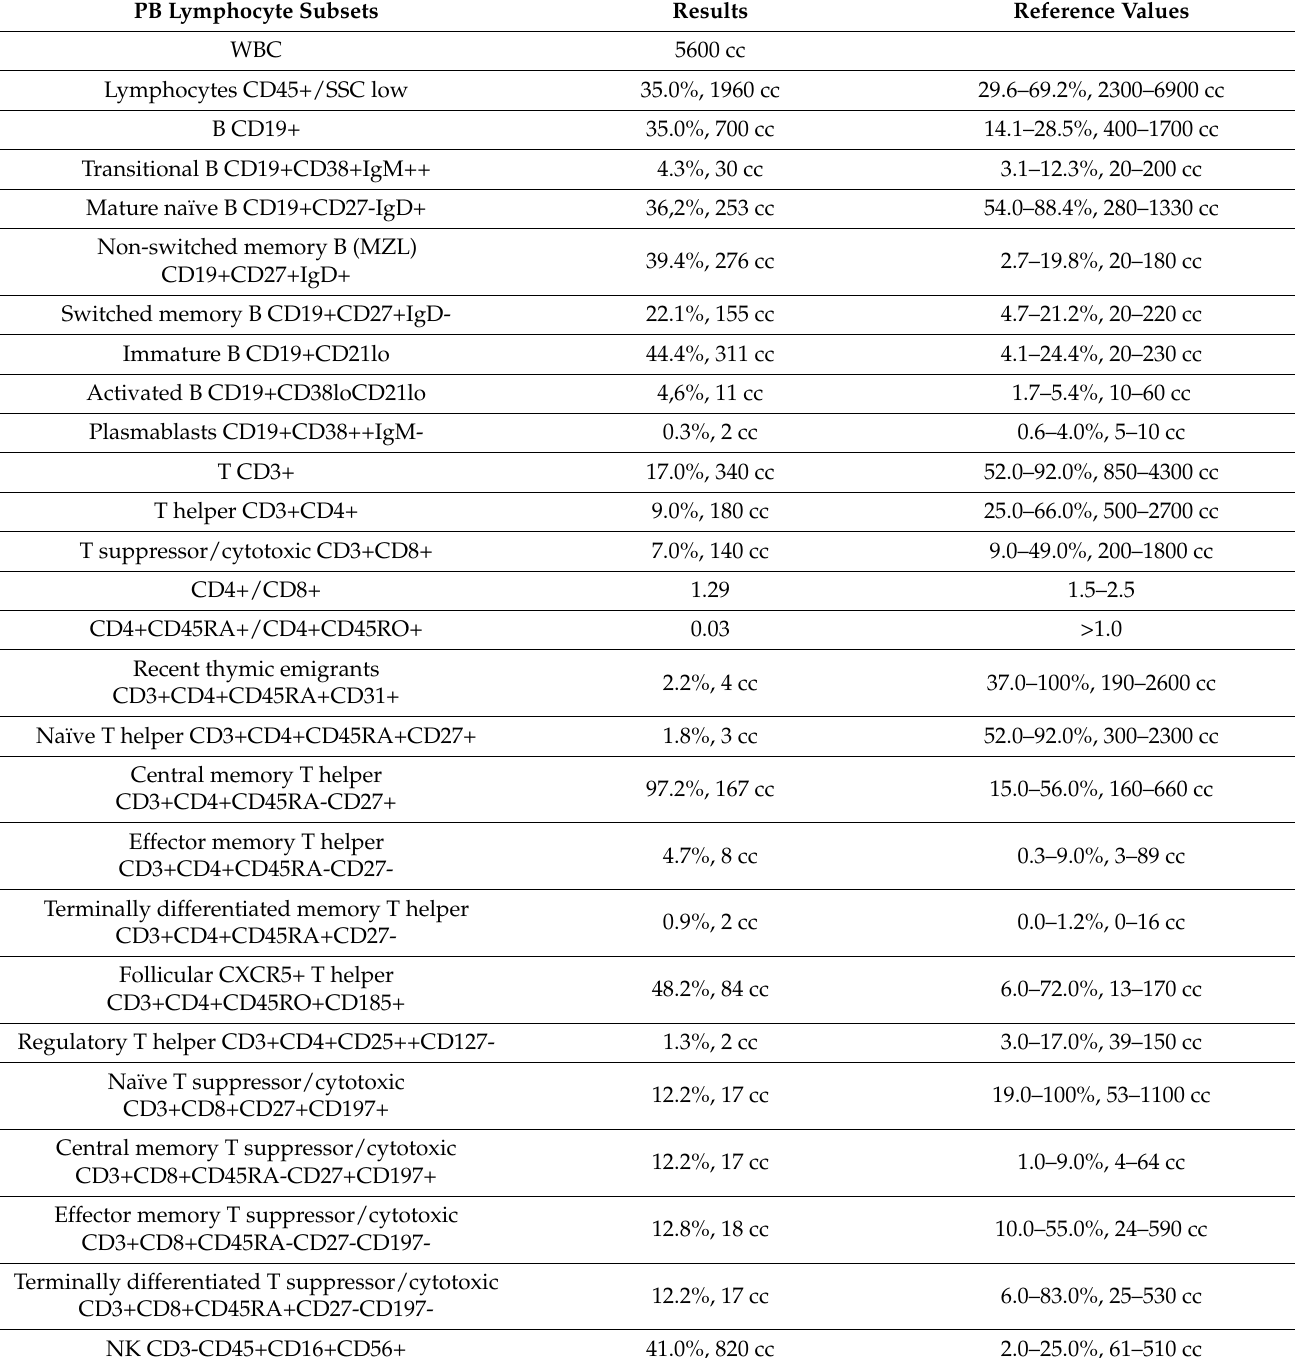
Table 1. The PB lymphocyte subsets in the patient aged 2-years-old, at the time of AT